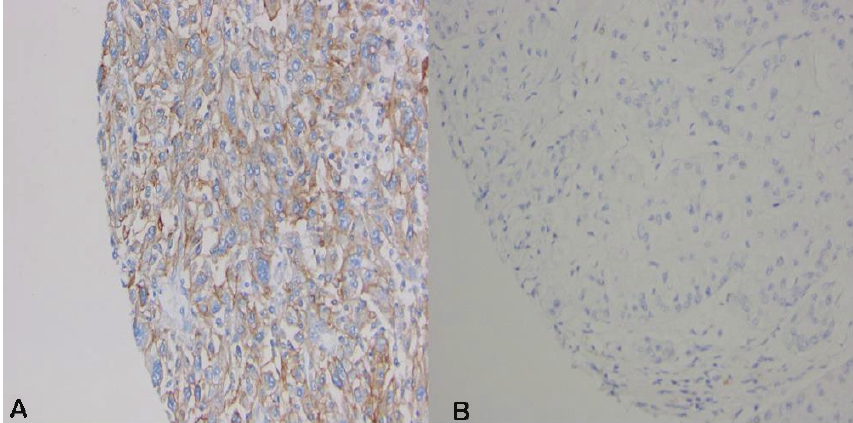
Figure 1. FFPE non-ccRCC specimens stained with anti-PD-L1 antibody (E1L3N). (A) Positive PD-L1 staining; ≥50% positivity (20X). (B) Negative PD-L1 staining; <1% positivity